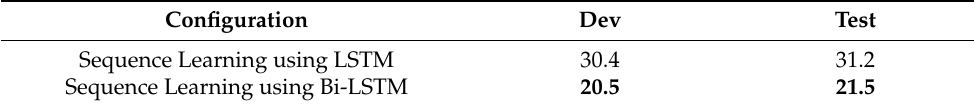
Table 4. WER Performance comparison using different sequence learning